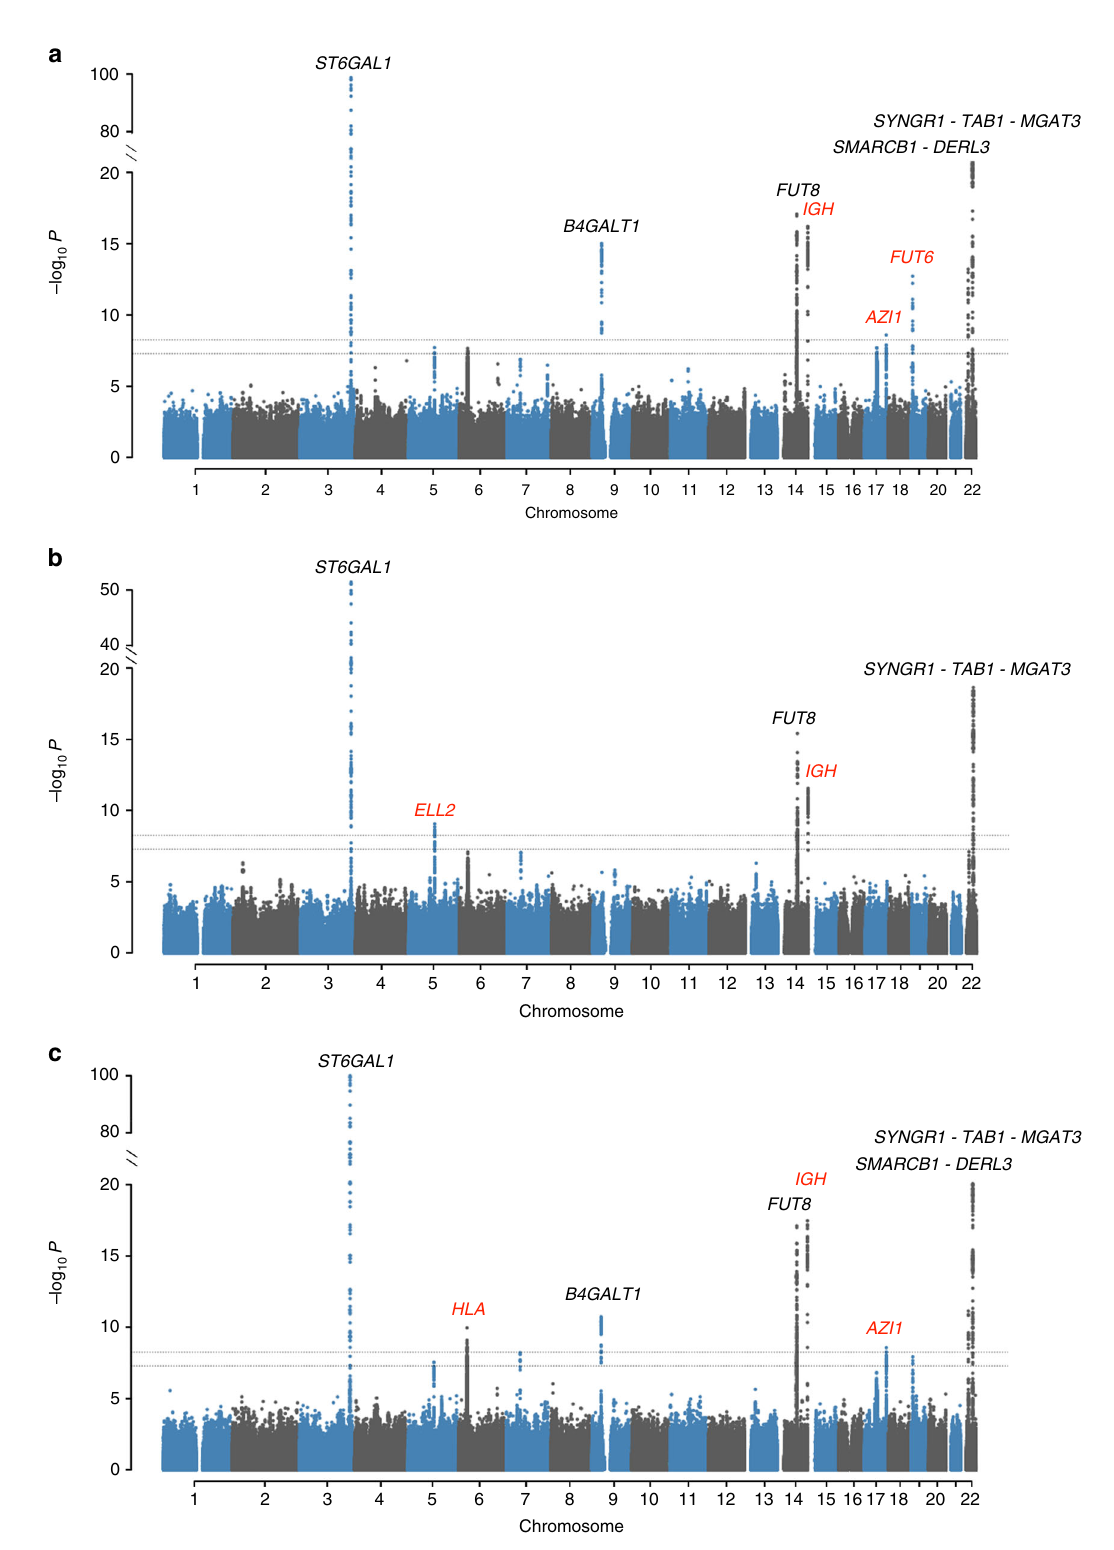
Fig. 1 Manhattan plots of multivariate GWAS for IgG N -glycosylation phenotypes in the ORCADES discovery population. The known and novel loci are labeled in black and red , respectively. 23 IgG N -glycosylation phenotypes were analyzed together and also in eight different functional subgroups, including sialylation and galactosylation. a Analysis of 23 N -glycosylation traits; b Analysis of eight sialylation phenotypes; c Analysis of 17 galactosylation phenotypes. The horizontal dashed lines represent the genome-wide signi fi cant P -value threshold of 5×10 − 8 /9 = 5.6×10 − 9 and the genome-wide suggestive signi fi cant threshold of 5×10 −